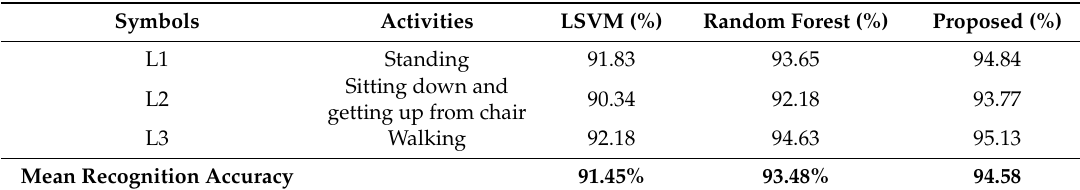
Table 12. The SMotion dataset applied over the proposed classifier and other well-known statistical classifiers.